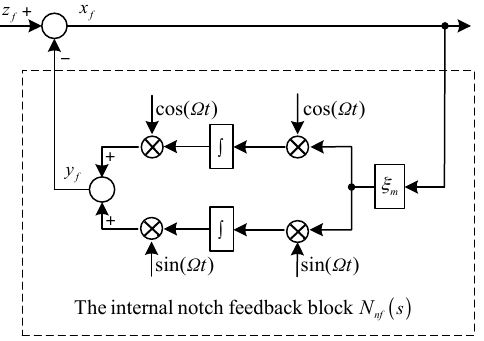
Figure 2. Structure of the closed-loop generalized notch filter.